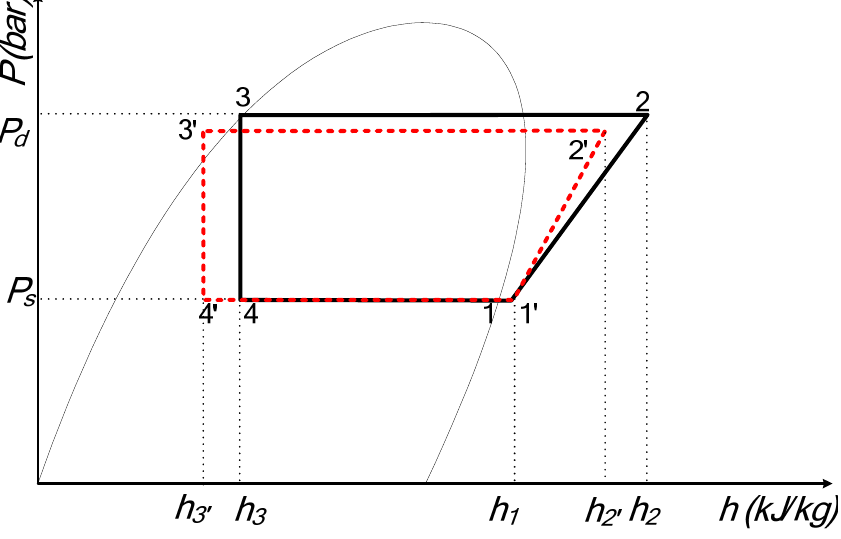
Figure 2. P – h diagram of refrigerant cycle in air-conditioning system with and without condensate as compressor-discharge cooler.